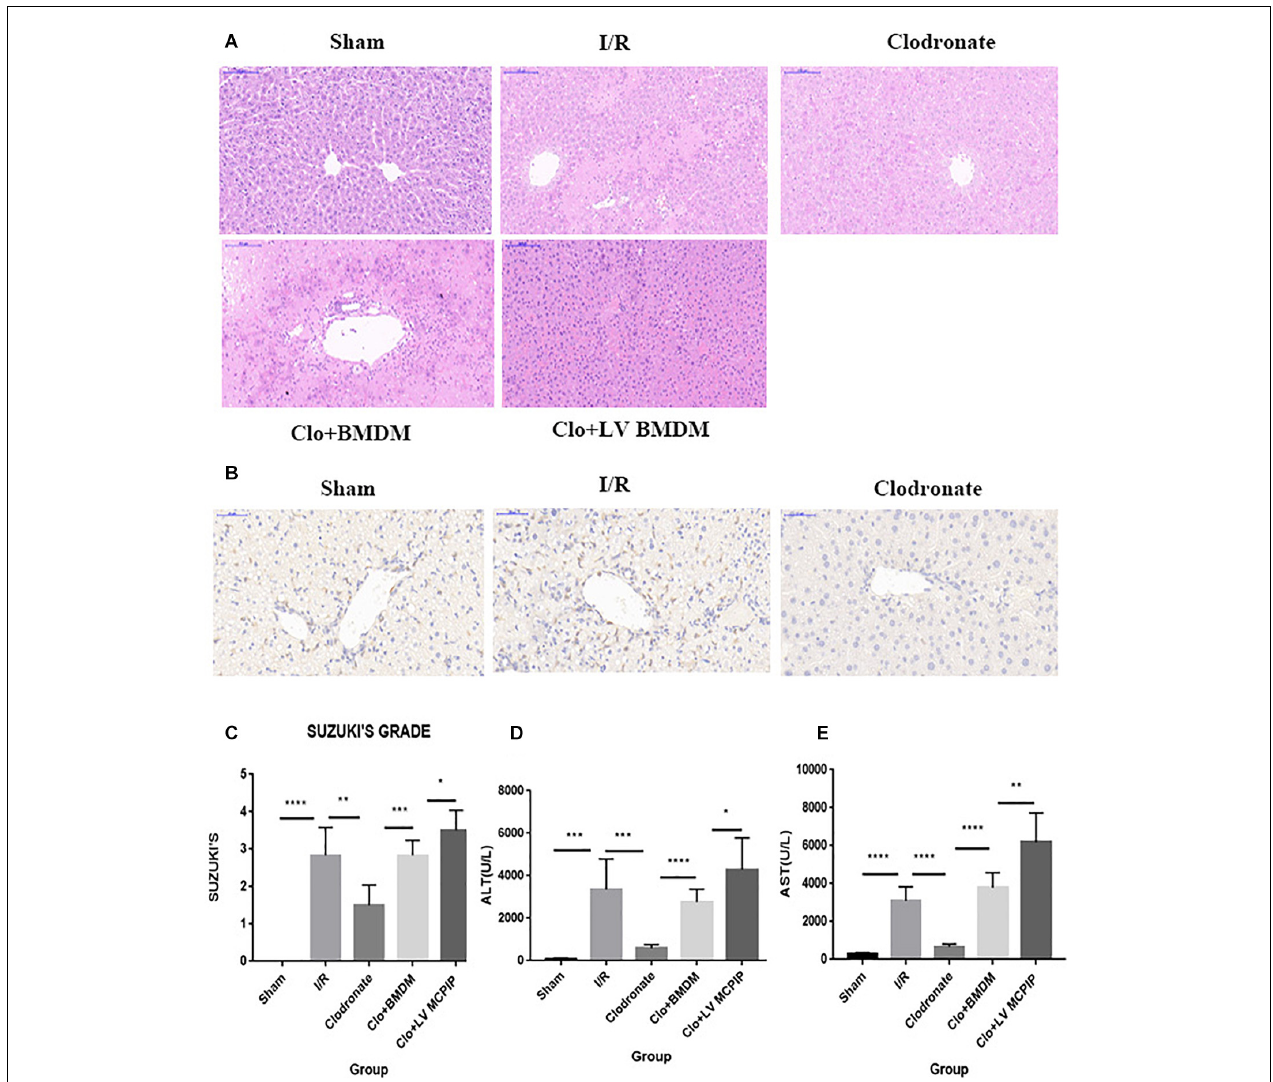
FIGURE 1 | MCPIP knockdown aggravated liver IR injury in C57BL/6 mice. (A) Representative histological staining using hematoxylin-eosin (H&E) was demonstrated. Regarding congestion, vacuolization, and necrosis, livers in the I/R group showed severe impairments compared to those in the Sham group, but this severity was reversed in the Clodronate group. Impairments in the Clo + BMDM group turned aggravated again, which became worse in the Clo + LV-MCPIP DMBM group. (B) Immunohistochemical examination was performed to visualize the presence of Kupffer cells as F4/80 positive. The markedly increased F4/80 positive cells in the I/R group were observably absent in the Clodronate group. (C) Suzuki’s histological score was quantified. (D,E) Hepatocellular function was assayed by serum ALT and AST levels. * P < 0.05, ** P < 0.01, *** P < 0.005, and **** P <